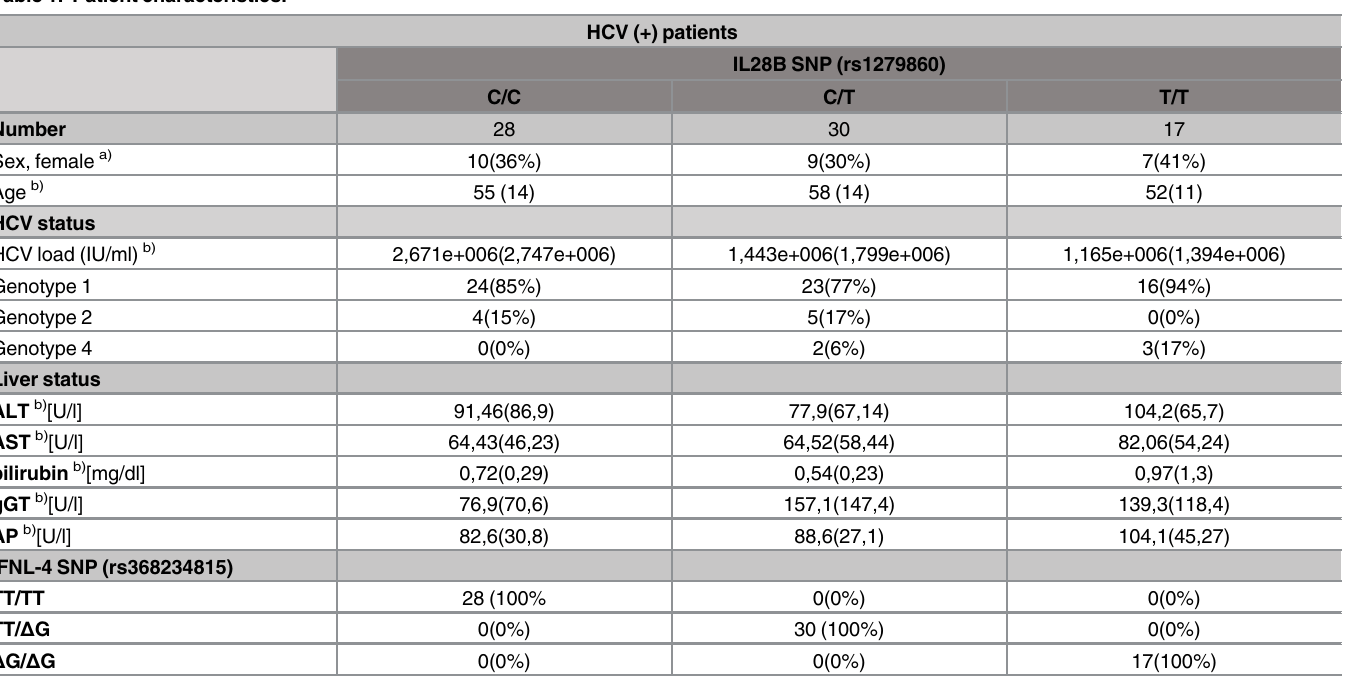
Table 1. Patient